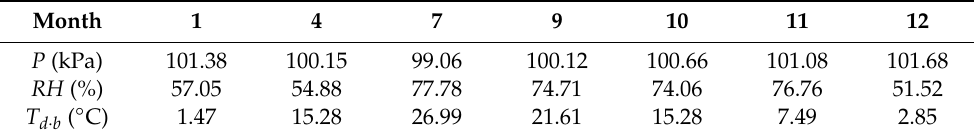
Table 1. Specific meteorological parameters in several typical months.